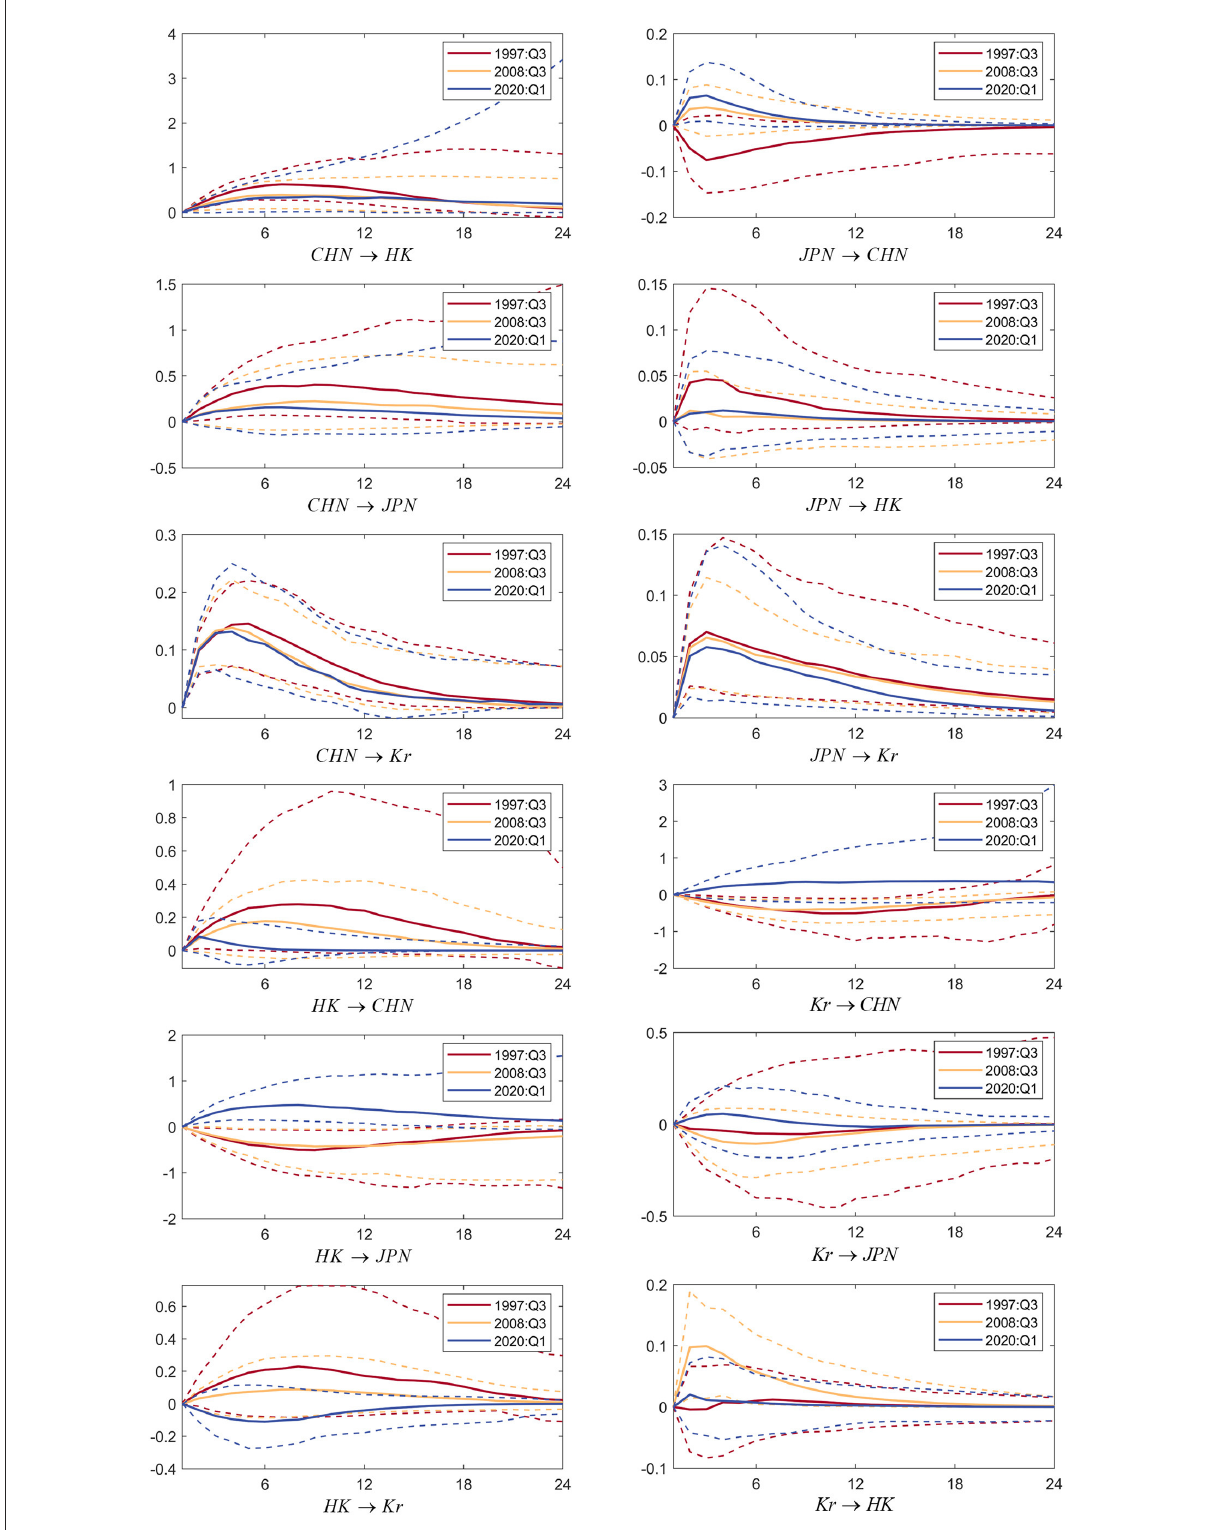
FIGURE5 The return spillovers among the stock markets of China, Japan, and South Korea at particular time points. Sources: Author’s own calculations. The upper and lower dotted lines represent the 10th and 90th of the distribution of the SV-TVP-FAVAR; The solid line represents the impulse response at different special